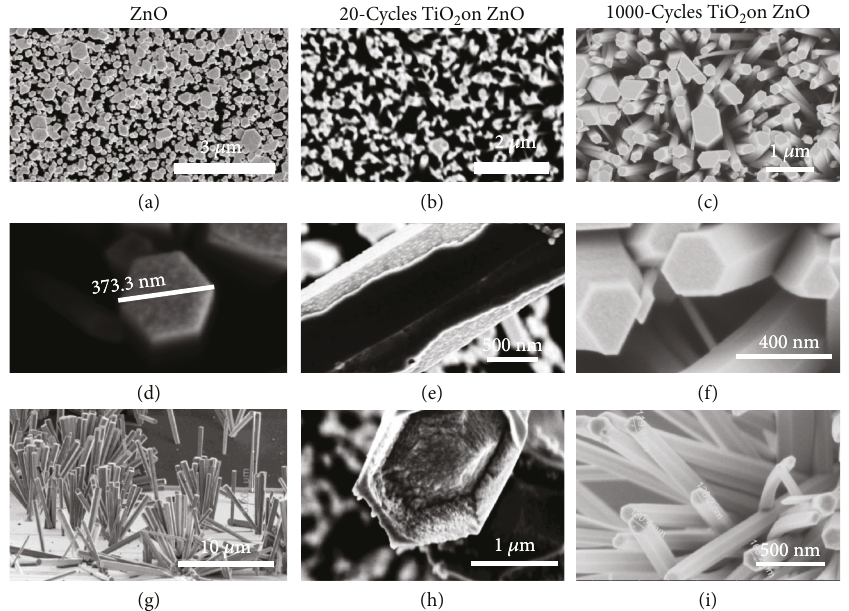
Figure 6: SEM images of ZnO, 20 cycles TiO @ZnO (incomplete coverage), and 1000 cycles TiO @ ZnO (complete and conformal coverage). 2 2 (a) Top-down view of ZnO nanowire forest, (b) top-down view of 20-cycle TiO -coated ZnO nanowire forest, (c) top-down view of 1000- 2 cycle TiO -coated ZnO nanowire forest, (d) single nanowire view of ZnO, showing hexagonal shape (single-crystalline), (e) single 2 on ZnO, showing incomplete coverage, (f) conformally and fully coated 1000-cycle TiO @ZnO, (g) side nanowire view of 20-cycle TiO 2 2 view of ZnO nanowires, (h) side view of 20 cycles TiO @ZnO, and (j) side view of 1000 cycles TiO @ZnO. 2 2